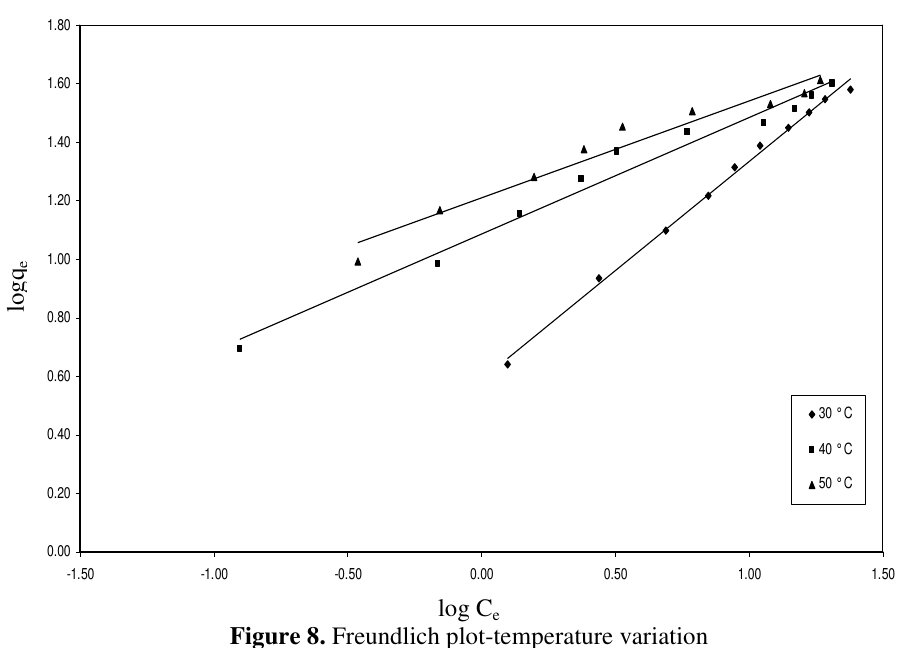
Figure 8. Freundlich plot-temperature variation Table 2. Parameters of Langmuir adsorption isotherm and Freundlich adsorption isotherms for methylene blue adsorption calculated for 100 minutes of agitation time onto activated babul seed carbon